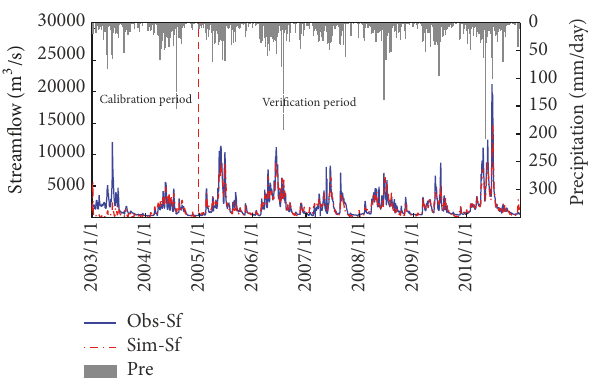
Figure 5: Daily precipitation, observed streamflow, and simulated streamflow by VIC model in the Ganjiang River basin from 2003 to